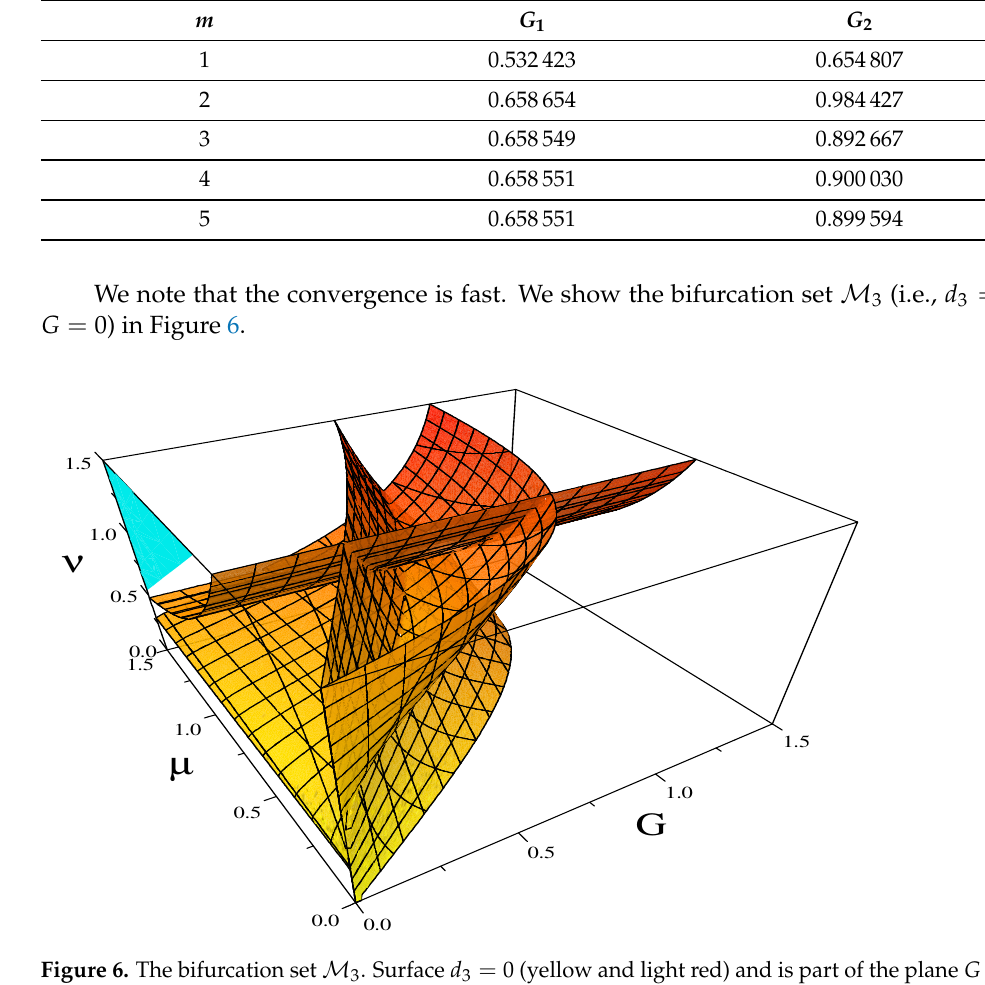
Figure 6. The bifurcation set M 3 . Surface d 3 = 0 (yellow and light red) and is part of the plane G = 0 (blue and